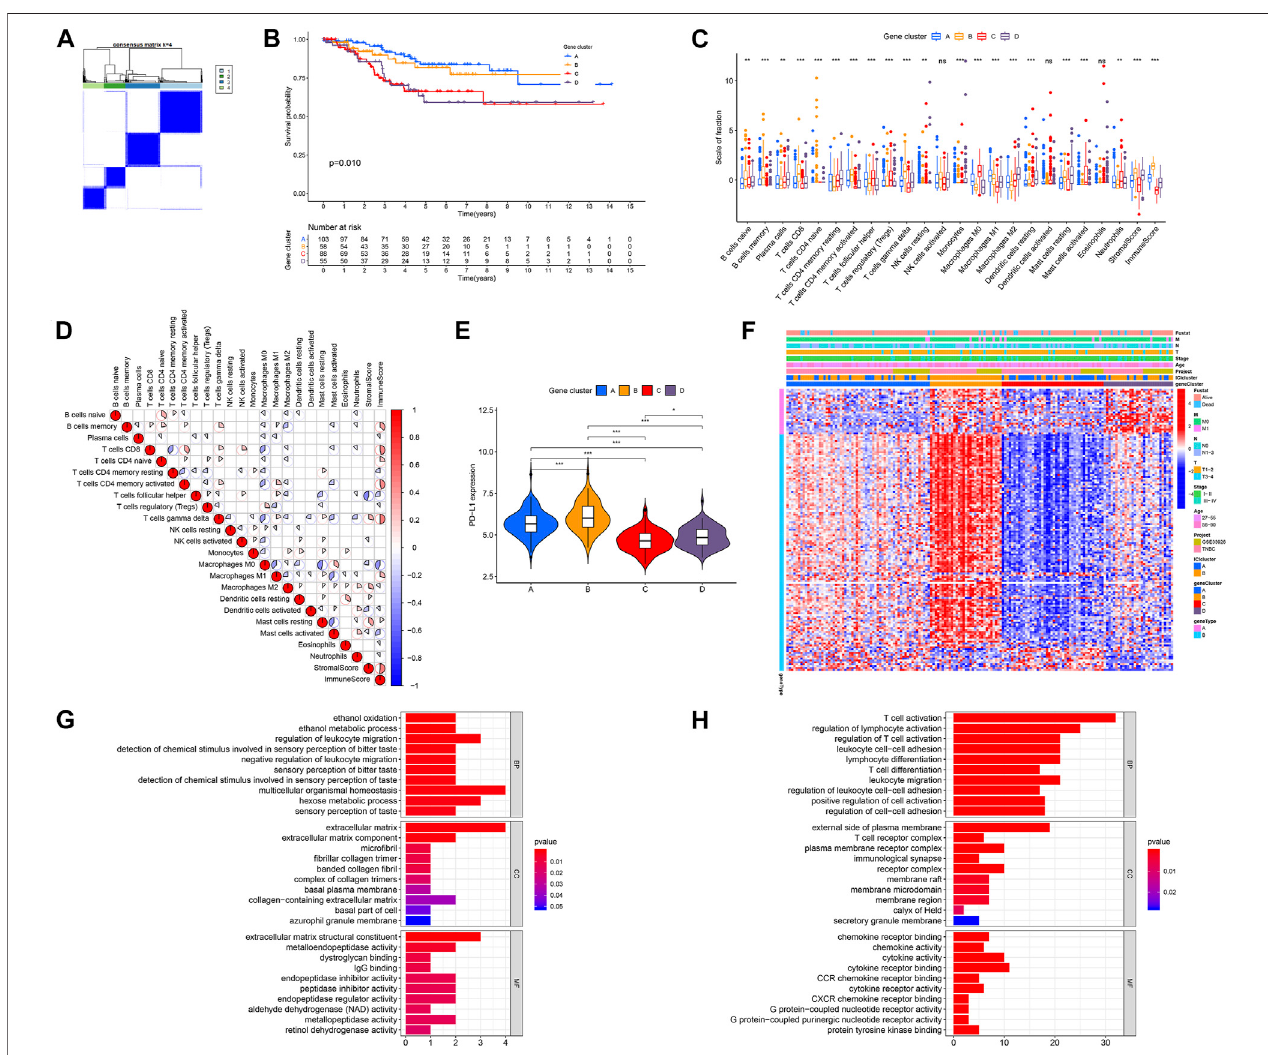
FIGURE 2 | Identi fi cation of immune gene subtypes in the discovery cohort of TNBC. (A) Unsupervised clustering was performed, and the discovery cohort was dividedintofourgeneclusters (A – D) . (B) KMAforfourgeneclusters, p =0.010. (C) Fractionof22tumor-in fi ltratingimmunecells,aswellasimmuneandstromalscores, amongfour geneclusters. (D) Interaction of22immunecells, aswellasimmune and stromal scores,in thediscovery cohortofTNBC. (E) PD-L1 expression levels inthe fourgeneclusters. (F) HeatmapofDEGsinfourgeneclusterswithdistinctclinicopathologicalcharacteristics. (G,H) GOanalysisofgenesignaturesA (G) andB (H) . * p < 0.05; ** p < 0.01; and *** p <